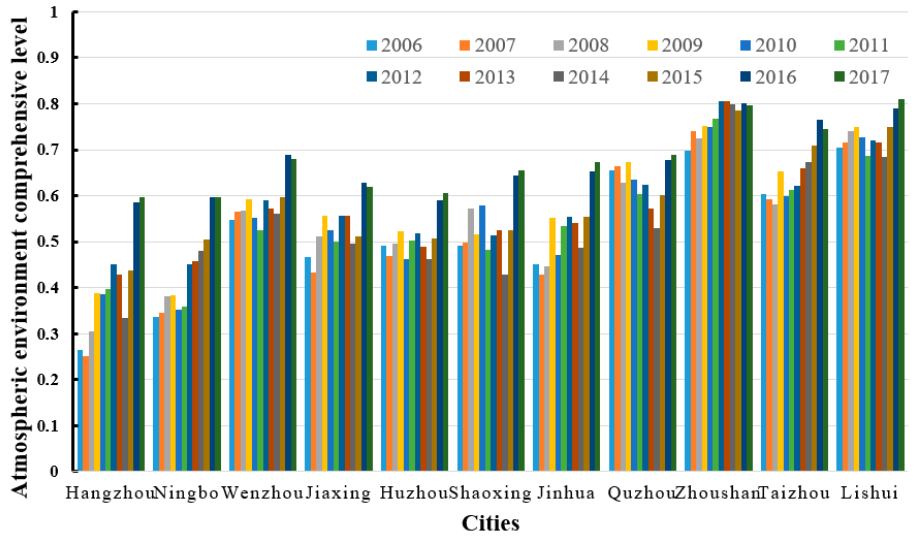
Figure 5. Trends in the atmospheric environment system scores of 11 cities in Zhejiang.